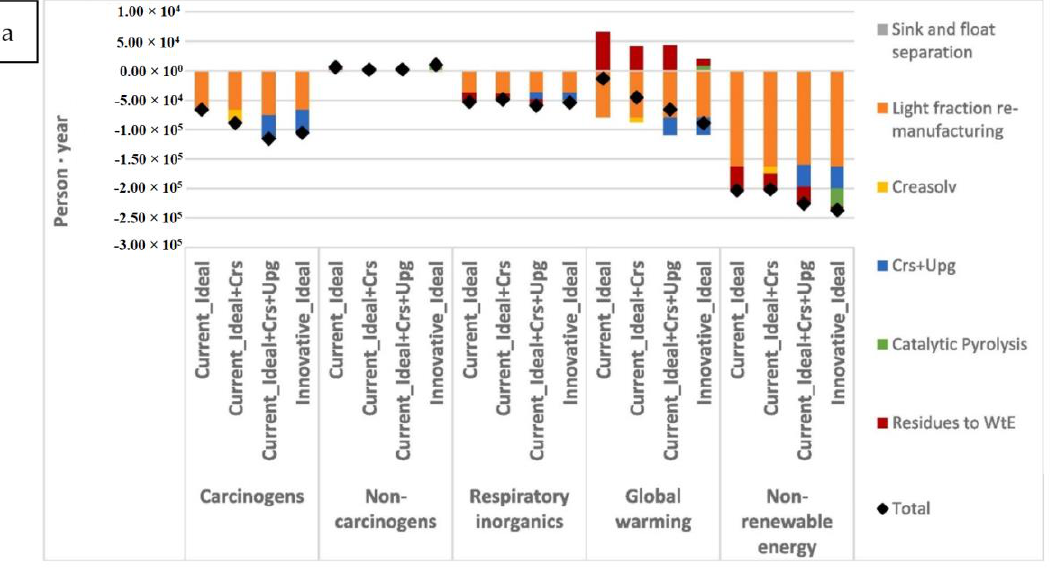
Figure 33. Normalized impact assessment data for the analyzed ( a ): Ideal and ( b ): Real scenarios concerning the functional unit and with the contribution of every single stage of the life cycle: Crs = CreaSolv ® ; Upg = Plastic Upgrading; Pyr = Catalytic Pyrolysis. The intermediates represent the current scheme where innovative processes are gradually added. The shaded rhombus indicates the total value for each impact category. Results are normalized in “Person · year” , i.e., the average impact in a specific category caused by a person during one year in Europe. Reprinted with permission from ref. [92]. Sixty-four percent of all plastic manufacturers in Ecuador are in Guayaquil City. Hi- dalgo-Crespo et al. [94] used LCA to determine the effects circumvented by the circular economy scenario for the city in terms of waste EPS materials. This assessment found that recycling EPS plastic waste significantly benefited the environment [94]. EPS-based food containers were assessed in a cradle-to-grave approach. The entire LCA was focused on different valorization paths: a circular economy closed-loop (container-to-container) pro- posal with an electricity share of 2019, and another with a future electricity share (2027), and a linear economy (container-to-landfill). Among these three scenarios, a circular econ- omy model for recycling post-consumer EPS waste with proposed 2027 electricity share (scenario C in Figure 34) had lesser environmental impacts in terms of terrestrial/ marine